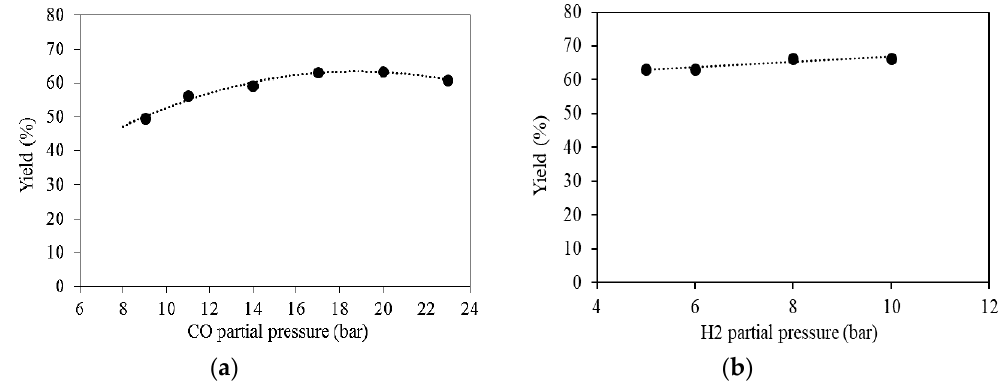
Figure 3. Effect of variable CO ( a ) and H 2 ( b ) partial pressures on the yield of 4,4-dimethyl- γ -butyrolactone formed by cyclocarbonylation of 2-methyl-3-buten-2-ol. Reaction conditions: 0.1 M 2-methyl-3-buten-2-ol, 4 mol% Pd(OAc) 2 , 16 mol% DPEphos, 1.0 g [BMIM]Cl, 5 mL DCM, 100 °C, 28 bar ( a : 5 bar H 2 , b : 18 bar CO), 18 h.